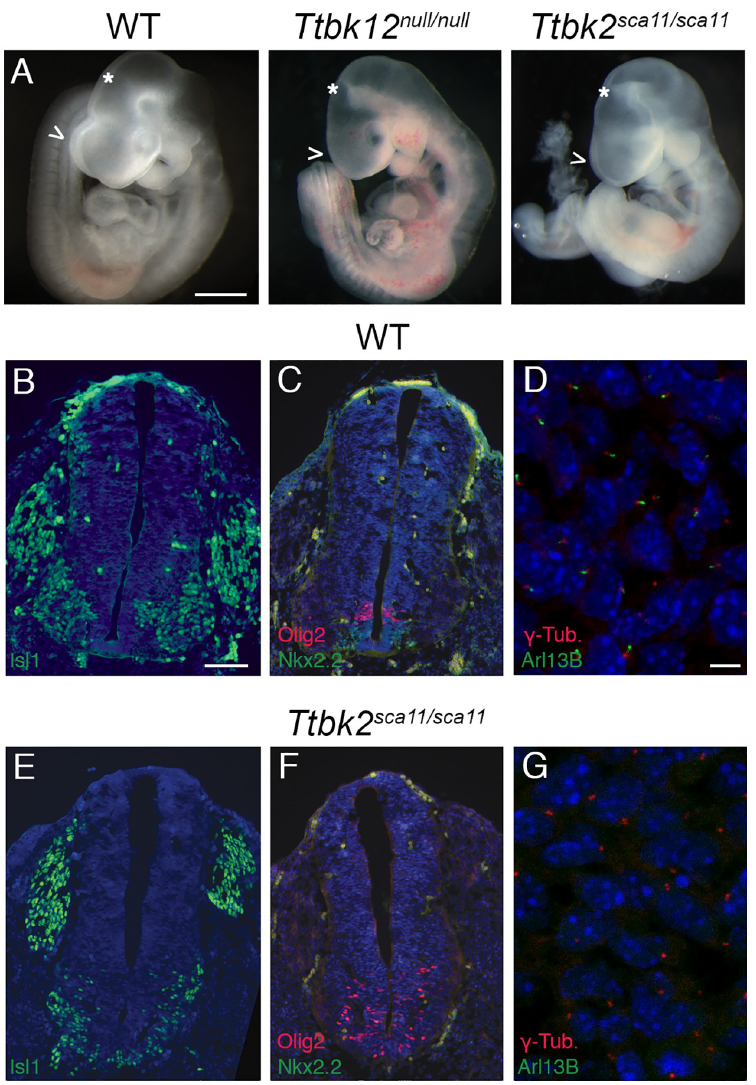
Fig 1. The phenotype of Ttbk2 sca11/sca11 embryos is identical to that of the null allele. (A) Representative wild-type, Ttbk2 null/null , and Ttbk2 sca11/sca11 E10.5 embryos, as indicated. Scale bar = 1mm. Arrowheads point out the forebrain, which in Ttbk2 null/nul and Ttbk2 sca11/sca11 fails to form two distinct hemispheres (holoprosencephaly). � Indicates the midbrain flexure which in both mutants is narrowed and takes on a pointed appearance, similar to other mutants with disrupted cilia and SHH signaling. (B-C, E-F) Transverse sections through neural tubes of wild-type (B-C) and Ttbk2 sca11/sca11 (E-F) E10.5 embryos. Sections were taken at the level of the forelimbs and immunostained for ISL1 (B, E) to label differentiated motor neurons or NKX2.2 and OLIG2 (C, F) to label V3 interneuron progenitors and motor neuron progenitors, respectively. Scale bar = 100 μ m. (D, G) Mesenchymal cells surrounding neural tube of E10.5 WT and Ttbk2 sca11/sca11 embryos, immunostained for ARL13B to label cilia (green) and γ -Tubulin (red). Scale bar = 13 μ m.